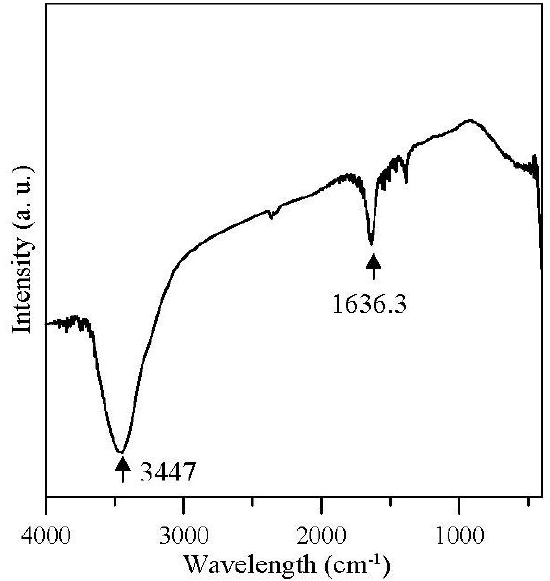
Figure 2. Fourier transform infrared (FTIR) spectra of Ag/BC particles.